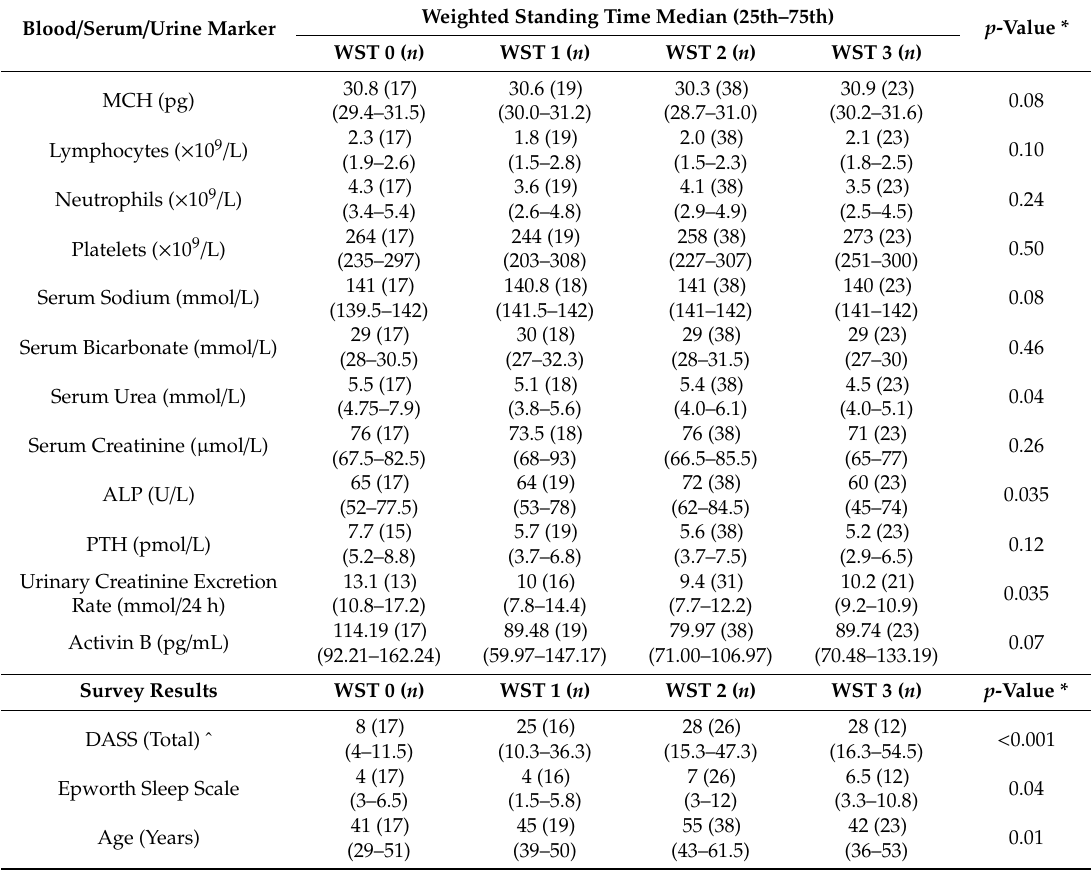
Table 3. Comparison of pathology markers, questionnaire results and serum Activin B for ME / CFS sub-cohorts stratified by the Weighted Standing Time (WST) symptom severity scale, compared with a control cohort of healthy participants. Results summarised as medians and 25th–75th